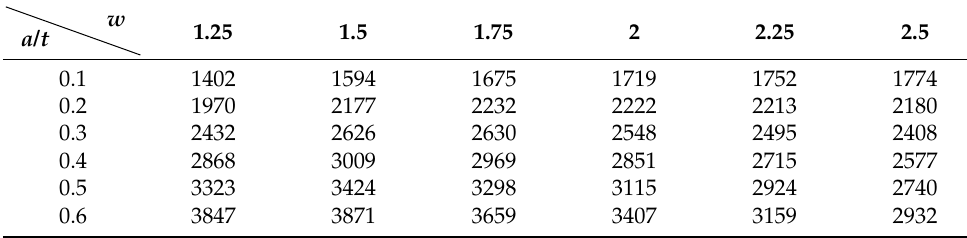
Table A1. Stress intensity factors with two